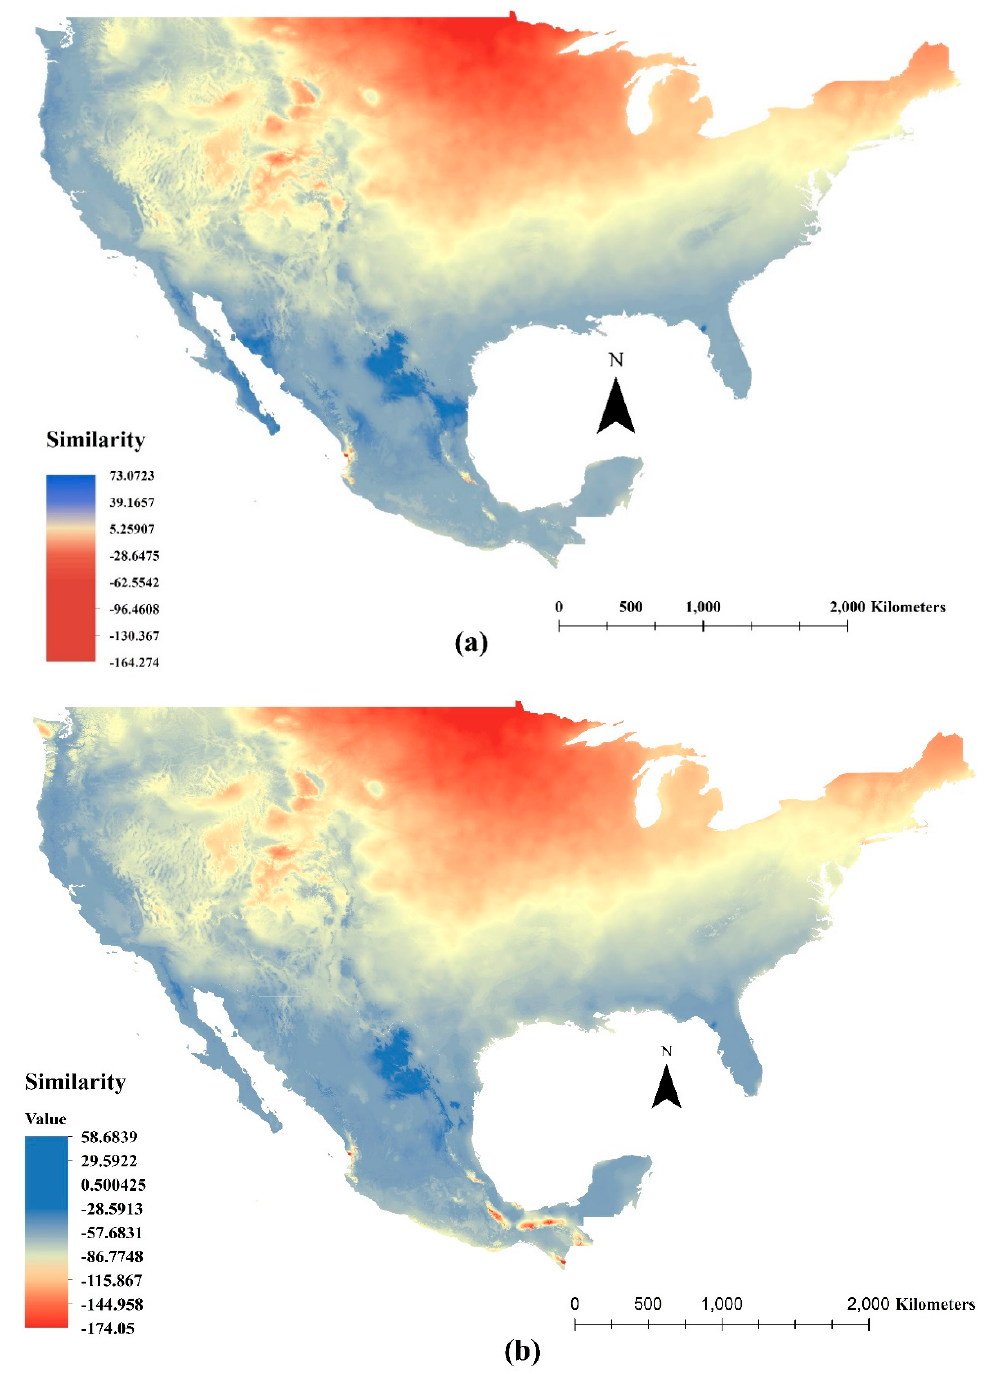
Figure 5. Mess analysis in North America for ( a ) Cactoblastis cactorum , ( b ) Apanteles opuntiarum. Scale bar shows the analogous level between the calibration (Argentina) and the transference areas (North America). Dark blue color and positive values indicate sites with climatic conditions similar to those in the insect species’ native ecological niche; dark red color and negative values indicate degrees of dissimilarity and that at least one bioclimatic variable was outside the range of the insect species’ native niche